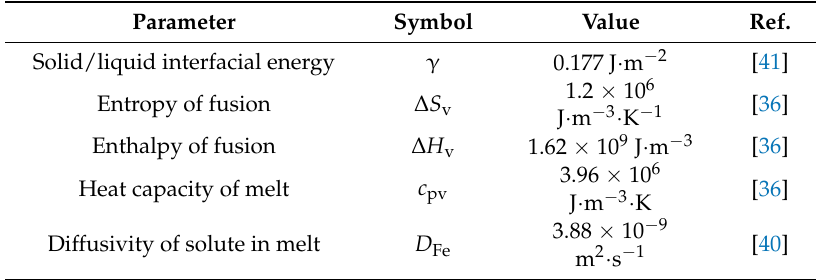
Table 3. Physical data used for